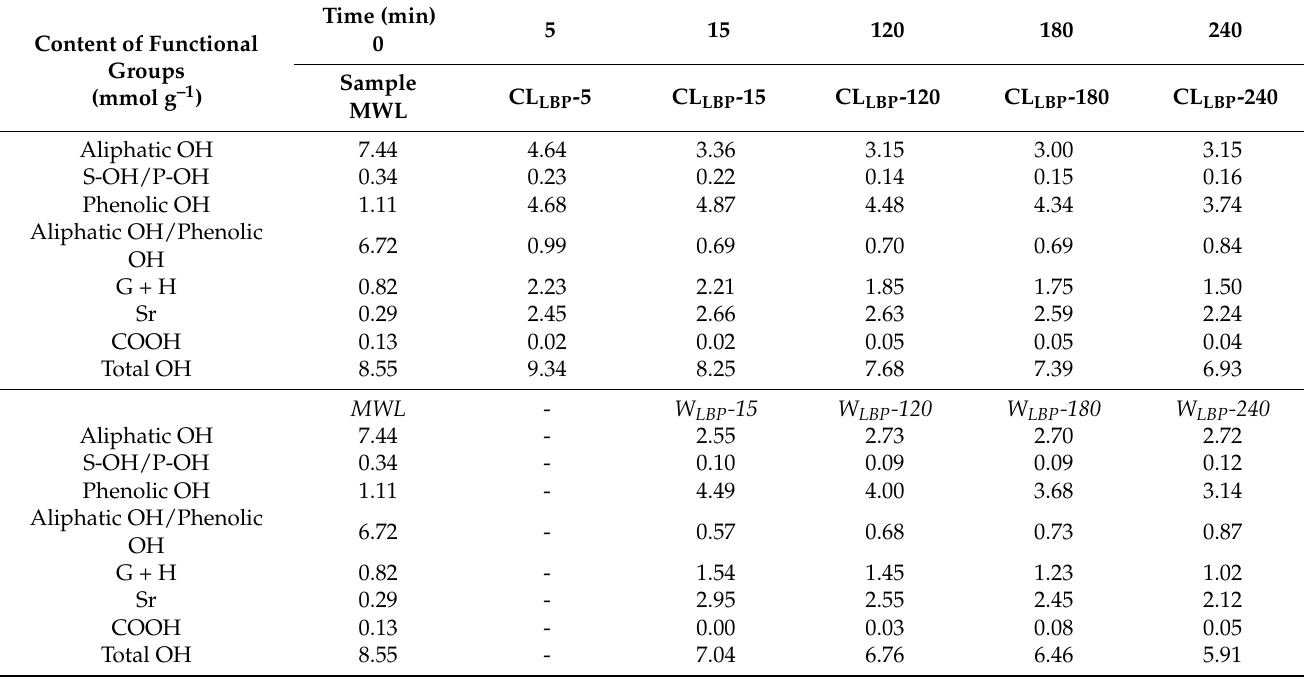
Table 1. Phenolic, aliphatic and carboxylic hydroxyl groups present in the examined lignin-based polymer (LBP) recovered after cellulose-lignin (CL LBP ) or wood (W LBP ) liquefaction at different times, determined by quantitative 31 P